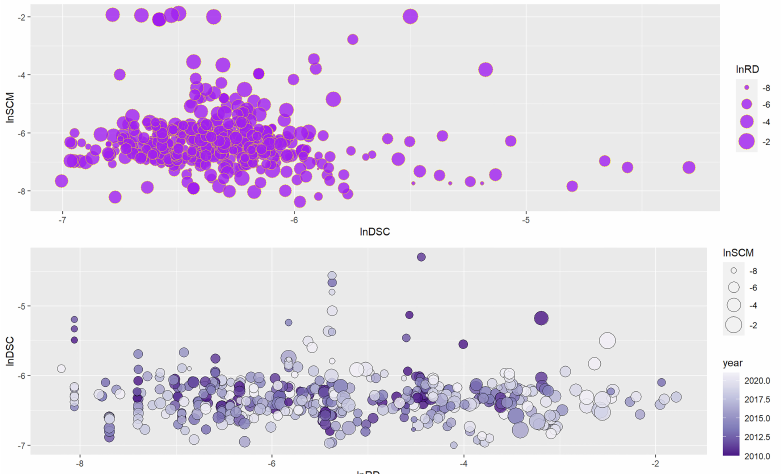
Figure 5. The scatter plot above (in magenta) represents: the relationship between debt service capacity (lnDSC) and supply chain management (lnSCM); the scatter plot below (in purple) represents: the relationship between debt service capacity (lnDSC) and R&D innovation